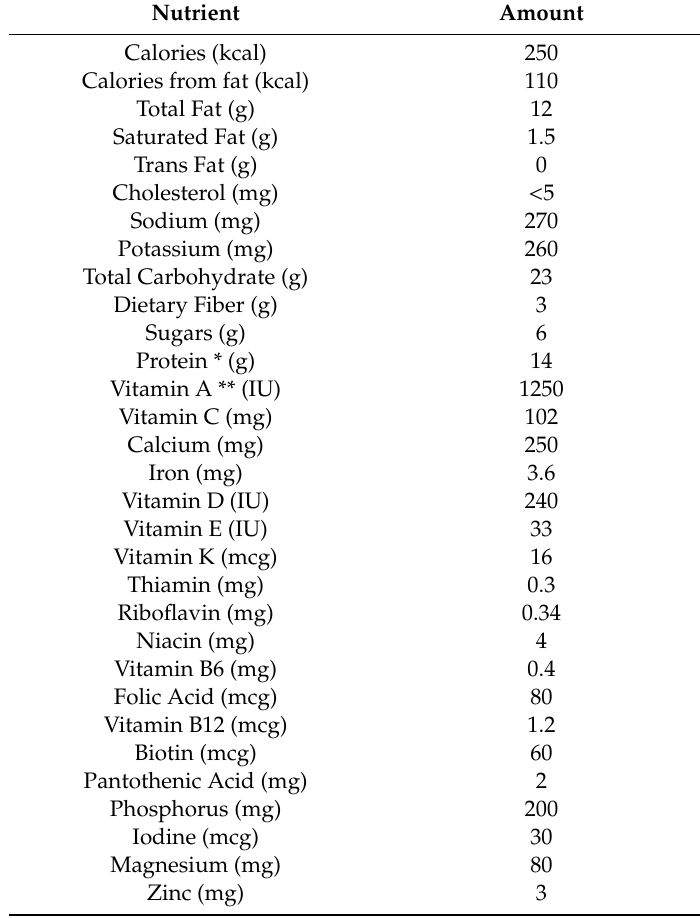
Table A1. Nutrient composition of 237 mL of the nutritional